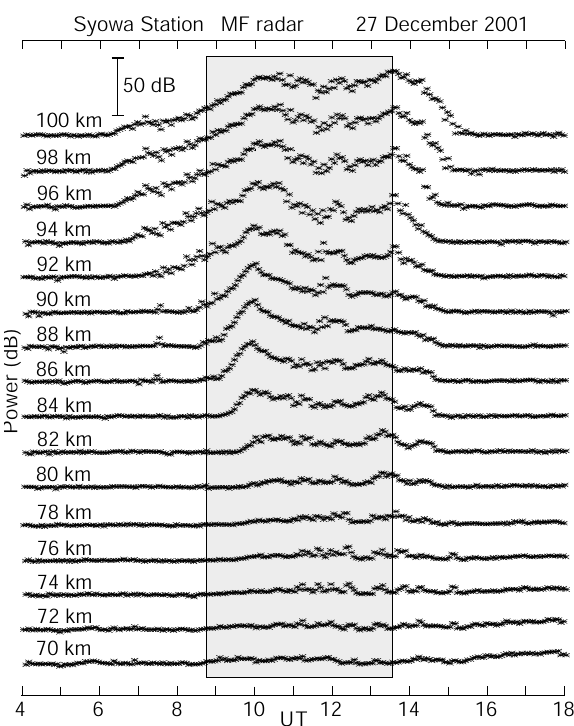
Fig. 8. Time and altitude variations of echo power observed with the Syowa MF radar. PMSE occurrence detected with the Syowa HF radar is lightly shaded.